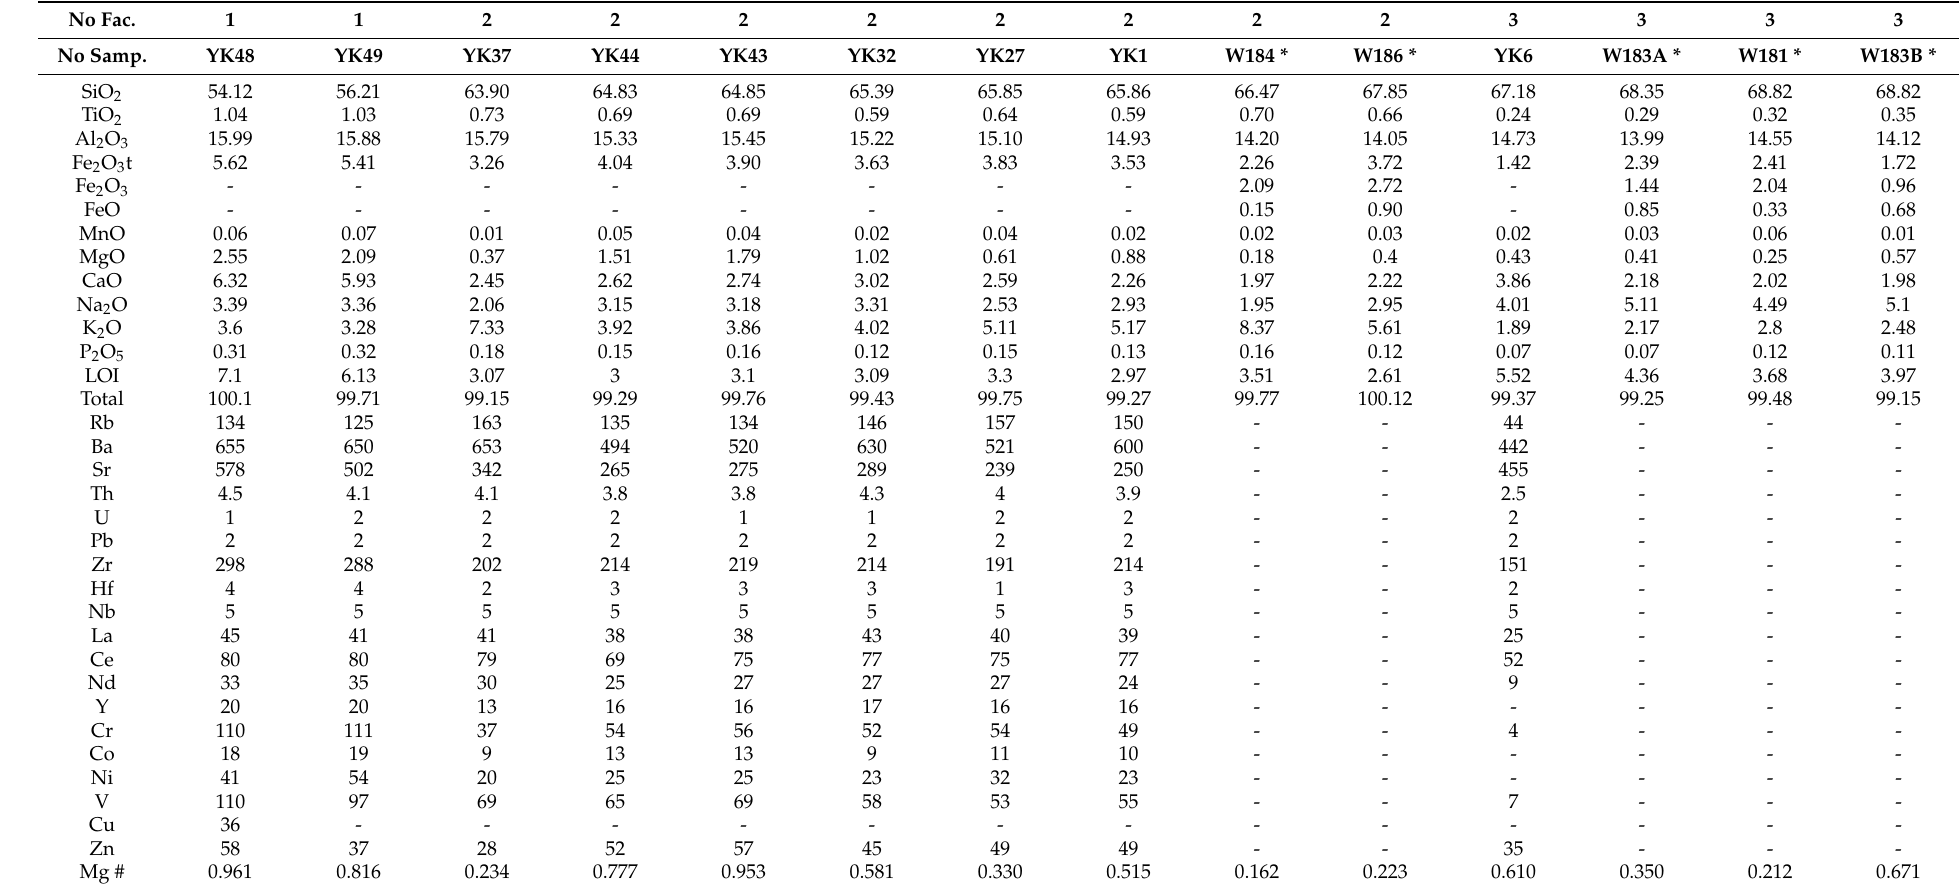
Table 1. Chemical compositions in major and traces elements of Tiddas-Souk Es Sebt des Ait Ikko volcanic complex magmatic rocks added to nine whole rock chemical analyses available in the literature (identified by an asterisk (*); [19,28]). Mg # = (MgO/40.32)/(Fe2O3t*0.9/71.8) + (MgO/40.32). No Fac. No